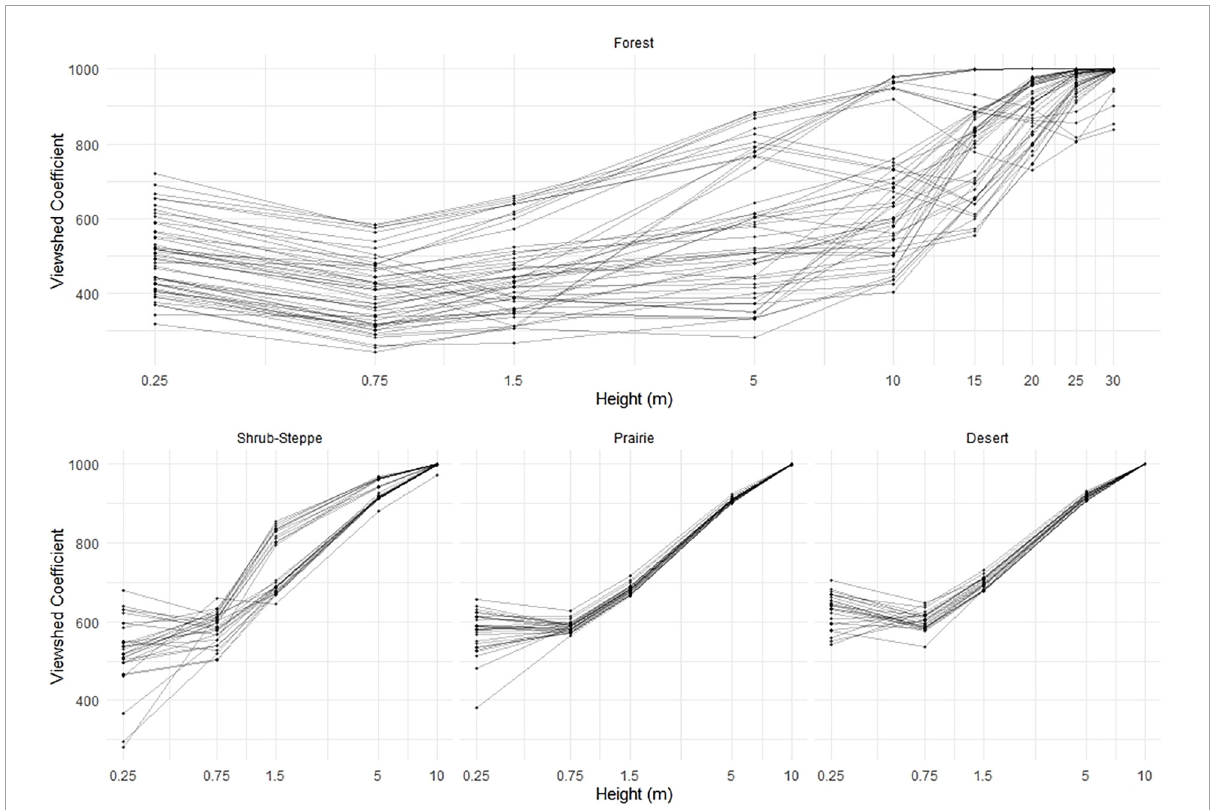
FIGURE5 Extent of viewsheds (estimated as the viewshed coefficient, VC) as a function of eye-height across four ecosystems (forest, shrub-steppe, prairie, and desert). Points represent viewsheds at individual vantage points ( n = 25–45/plot) within multiple plots per ecosystem ( n = 5–10 plots/ecosystem). Note that the x-axis is on a logarithmic